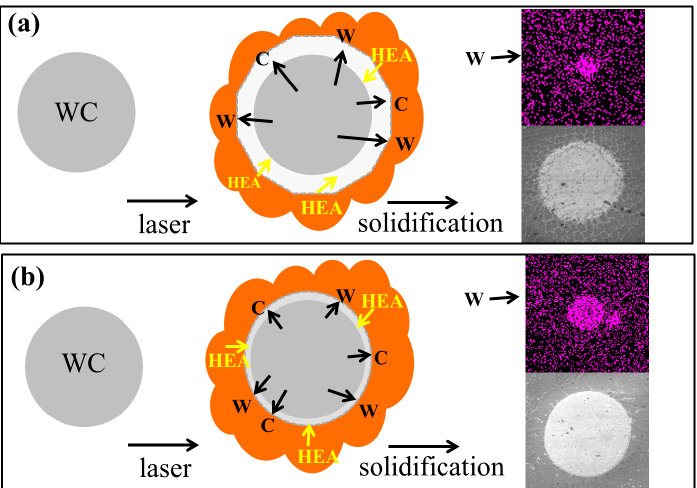
Figure 6. Schematic diagram of decomposition and solidification of WC particles. ( a ) Partial decomposition; ( b ) slight decomposition.